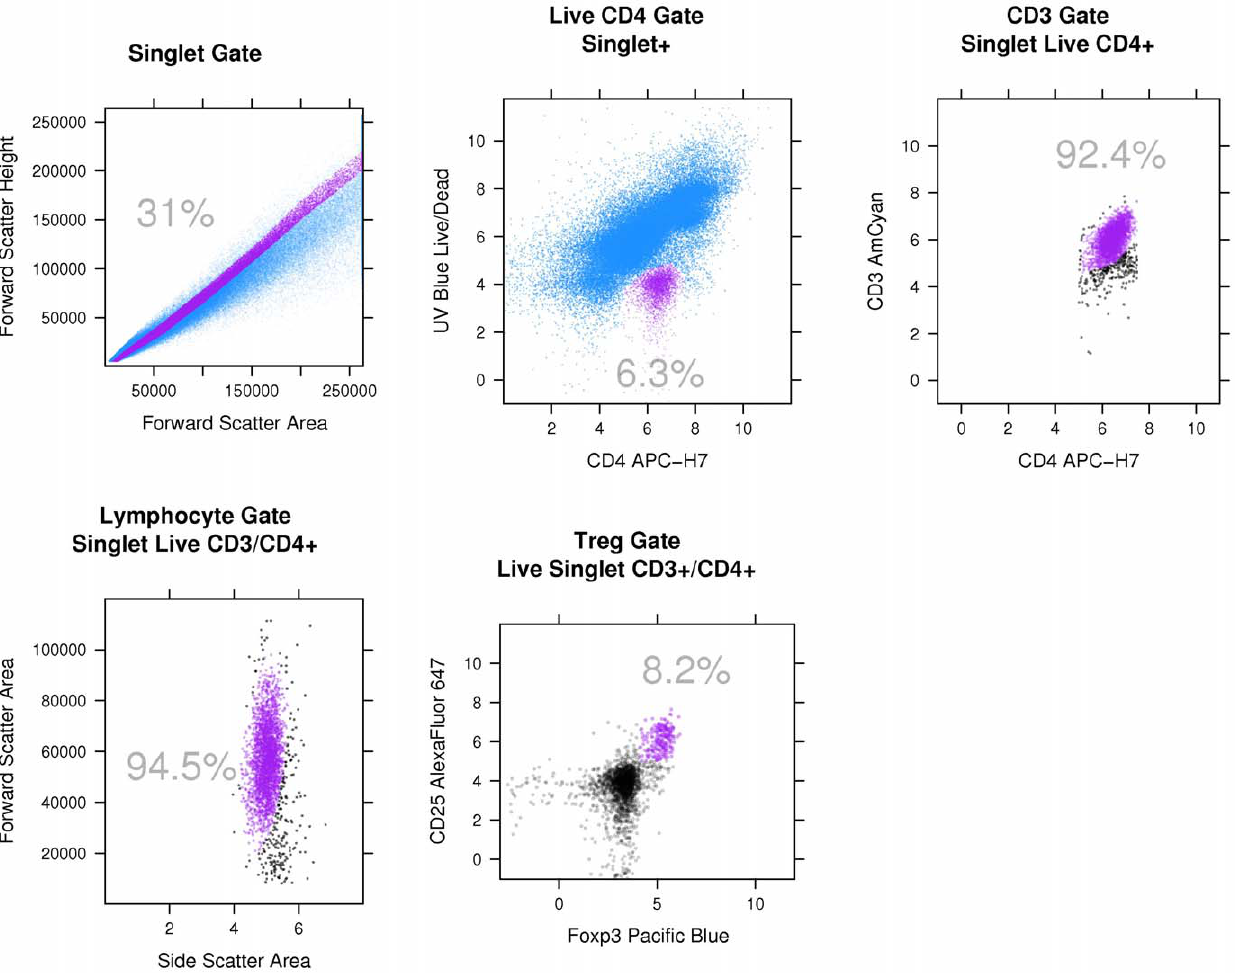
Figure 1. Representative gating strategy for identification of CD3 + CD4 + CD25 hi Foxp3 + lymphocytes and subsets. Gated cells (selected cells) are purple, while non-gated cells (discarded cells) are blue or black. The gating involves sequential boolean filters and the sequence of filters is demonstrated here moving left to right and then top to bottom. Purple cell populations are selected in each scatterplot and this population is then used as the parent population in the subsequent scatterplot. (top row) First, singlets are identified in a forward scatter-area vs. forward scatter-height plot and gated on prior to logicle transformation of the data. Live/CD4 + cells are then identified in a CD4 vs. UV-Blue plot. CD3 + cells are then identified in a CD4 vs. CD3 plot. (bottom row) Lymphocytes within this population are identified in a side scatter-area vs. forward scatter-area plot. Treg are identified in a Foxp3 vs. CD25 plot. Determination of gates for CD25, CD45RA, Foxp3 and CCR7 utilized fluorescence minus-one (FMO) tubes.